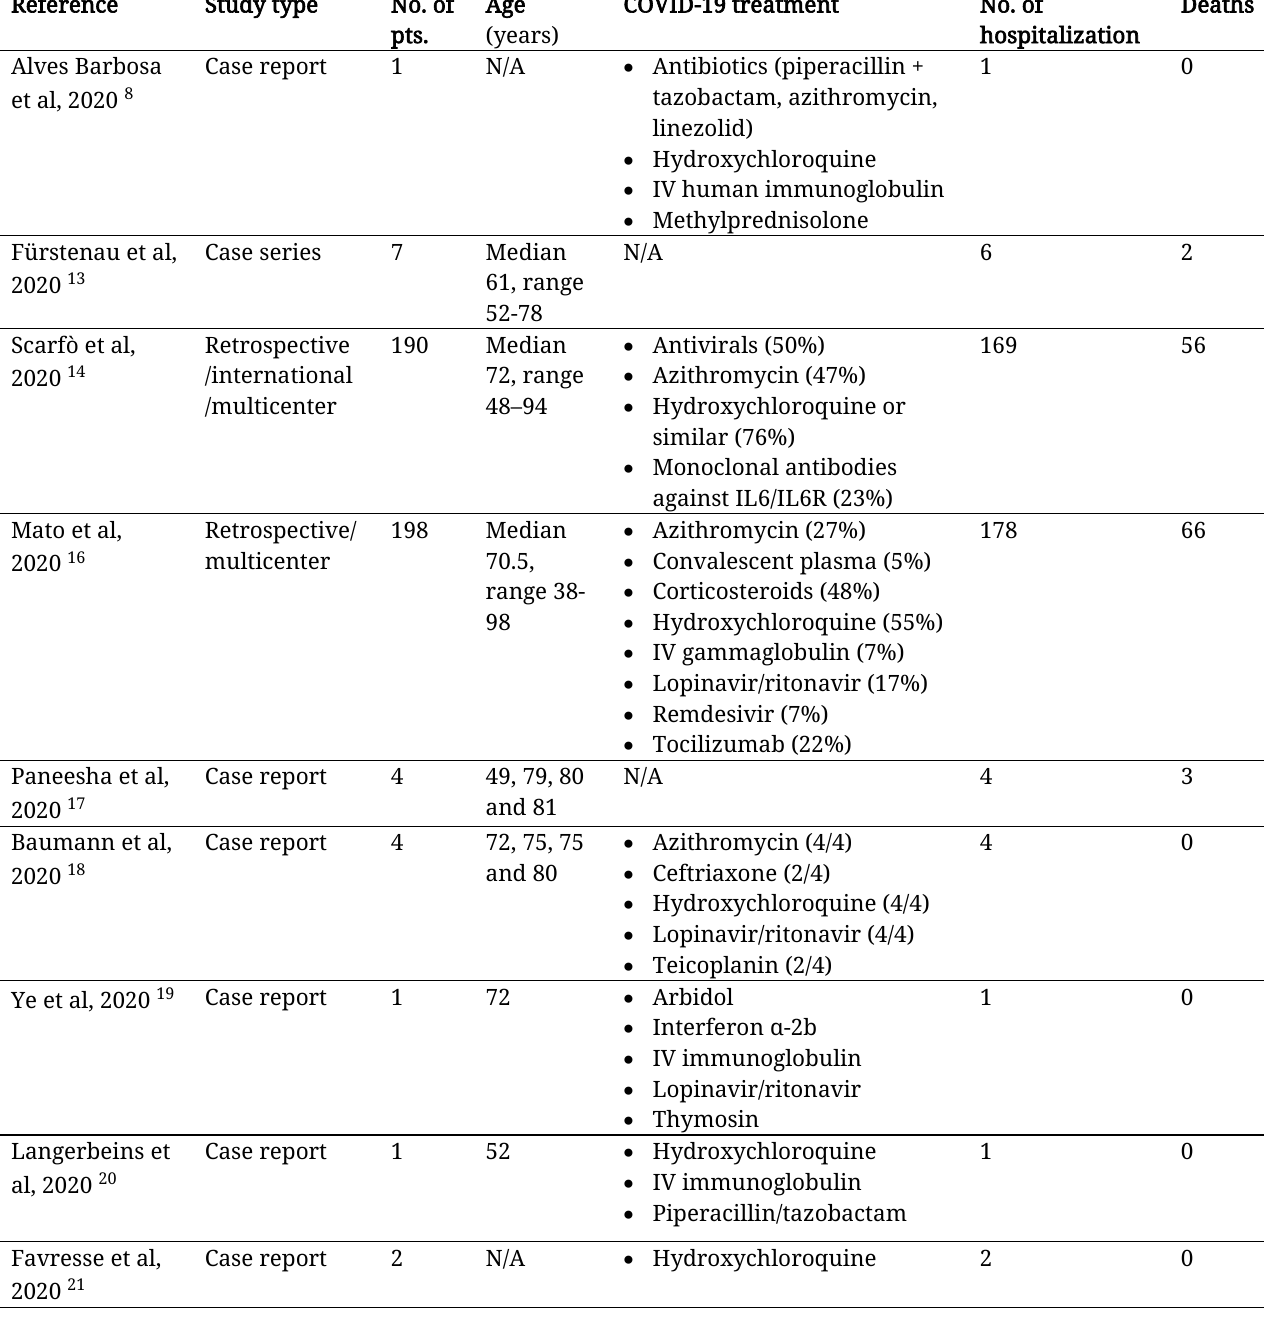
Table 2: Studies of COVID-19 in Chronic Lymphocytic Leukemia